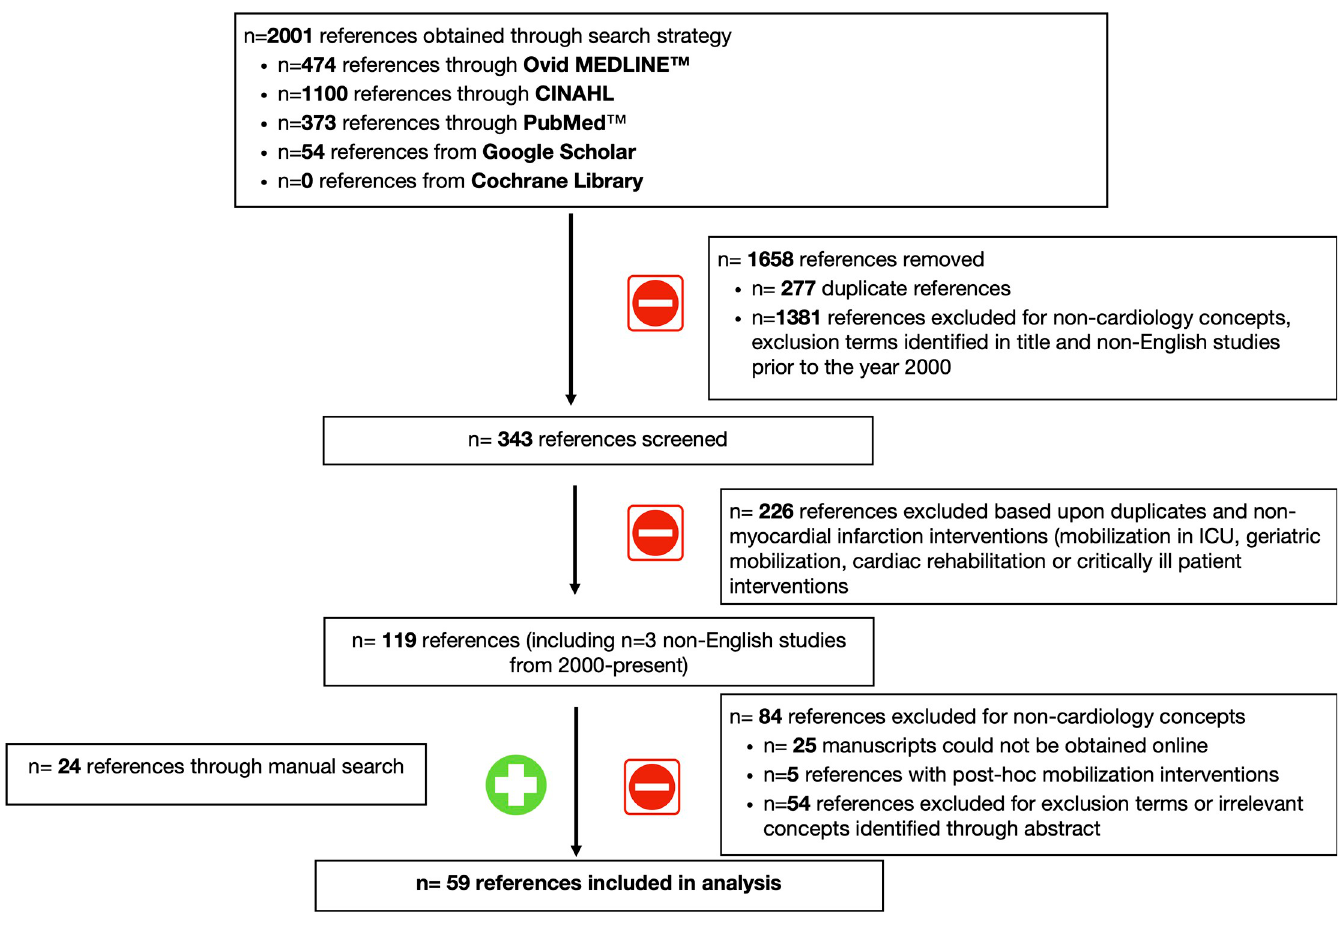
Fig 1. Search strategy